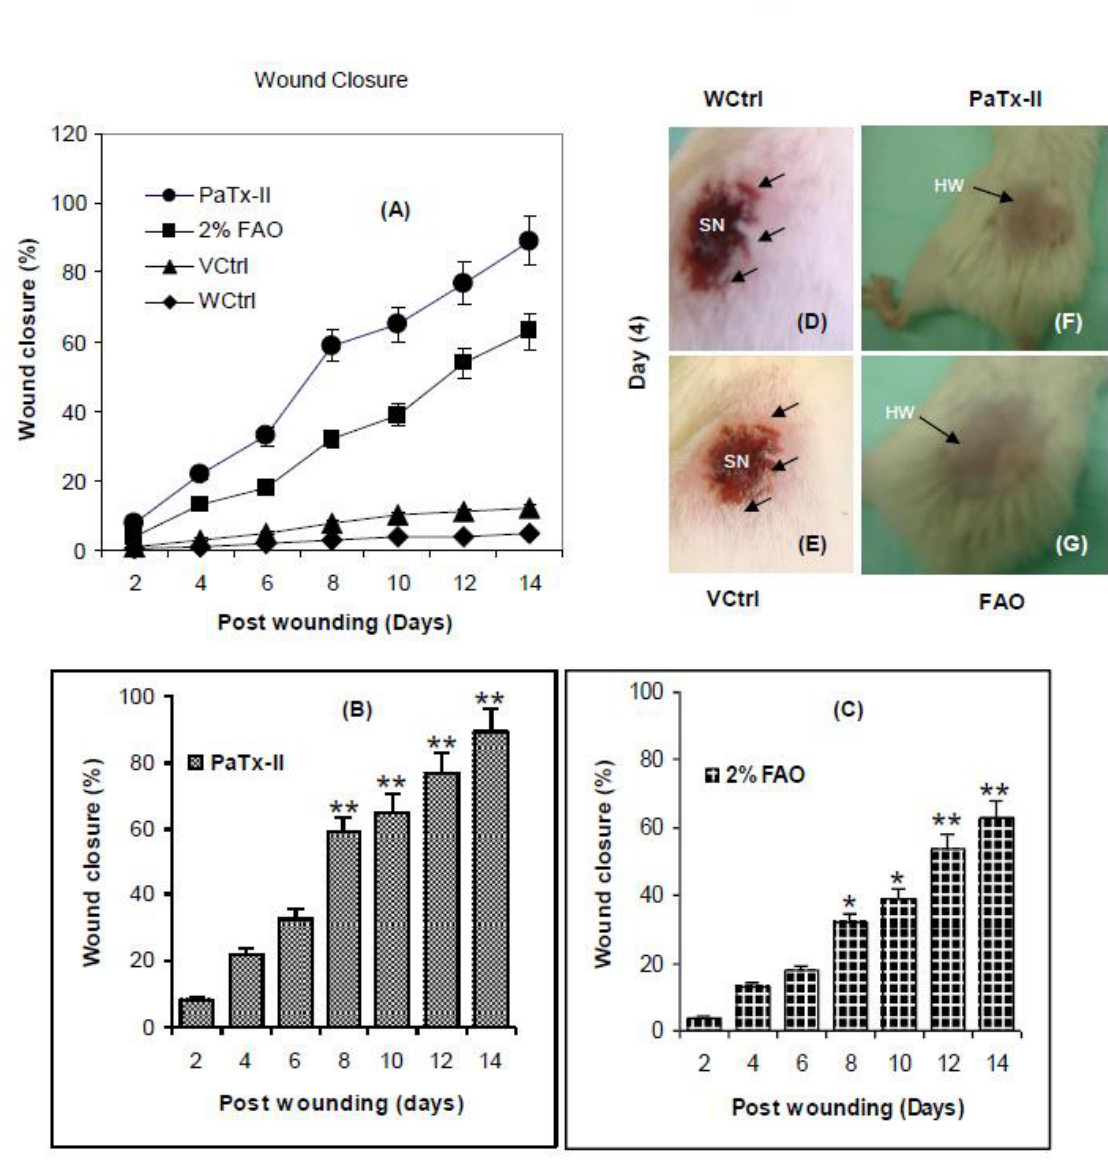
Figure 4. Wound healing effects of proteins in the mouse model. ( A ) S. aureus -infected wound treated with PaTx-II or fusidic acid ointment (FAO) shows enhanced healing when applied to mice at 0.5 mg/kg. Wound contraction was compared between the wound control (WCtrl) and vehicle control (VCtrl) mice. Control mice show severe necrosis (SN) and muscle damage after 4 days. ( B ) Percent reduction of wound after treatment with PaTx-II was analyzed between 2 and 14 days. The progress of the wound repair processes is indicated in days. ( C ) Post-treatment wound closure progression after treatment with 2% FAO (5 mice per group). HW represents the healing wound. Wound photographs: ( D ) Day 4, WCtrl. ( E ) Day 4, VCtrl. ( F , G ) Action of PaTx-II or FAO-completely healed wounds. ( A – C ) Data are the mean ± SD of 5 animals per group (n = 5) and represent three independent experiments. Statistical comparisons were performed with Prism 4.0 Software (Graph- Pad), using a two- tailed Student’s t -test for the comparison of two data sets, and ANOVA for multiple comparisons. Statistically significant differences are shown, with p values of * p < 0.05 and ** p < 0.01.